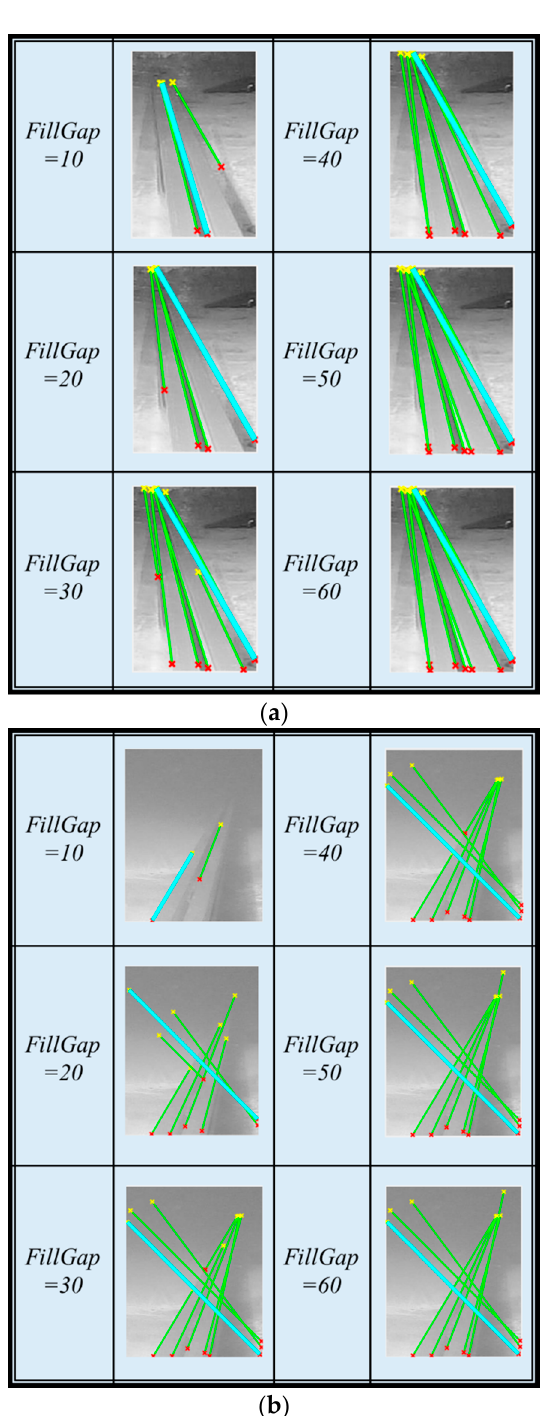
Figure 16. Comparison of various FillGap values of the target object measured in the ( a ) out-of-water environment; and ( b ) underwater environment, respectively.